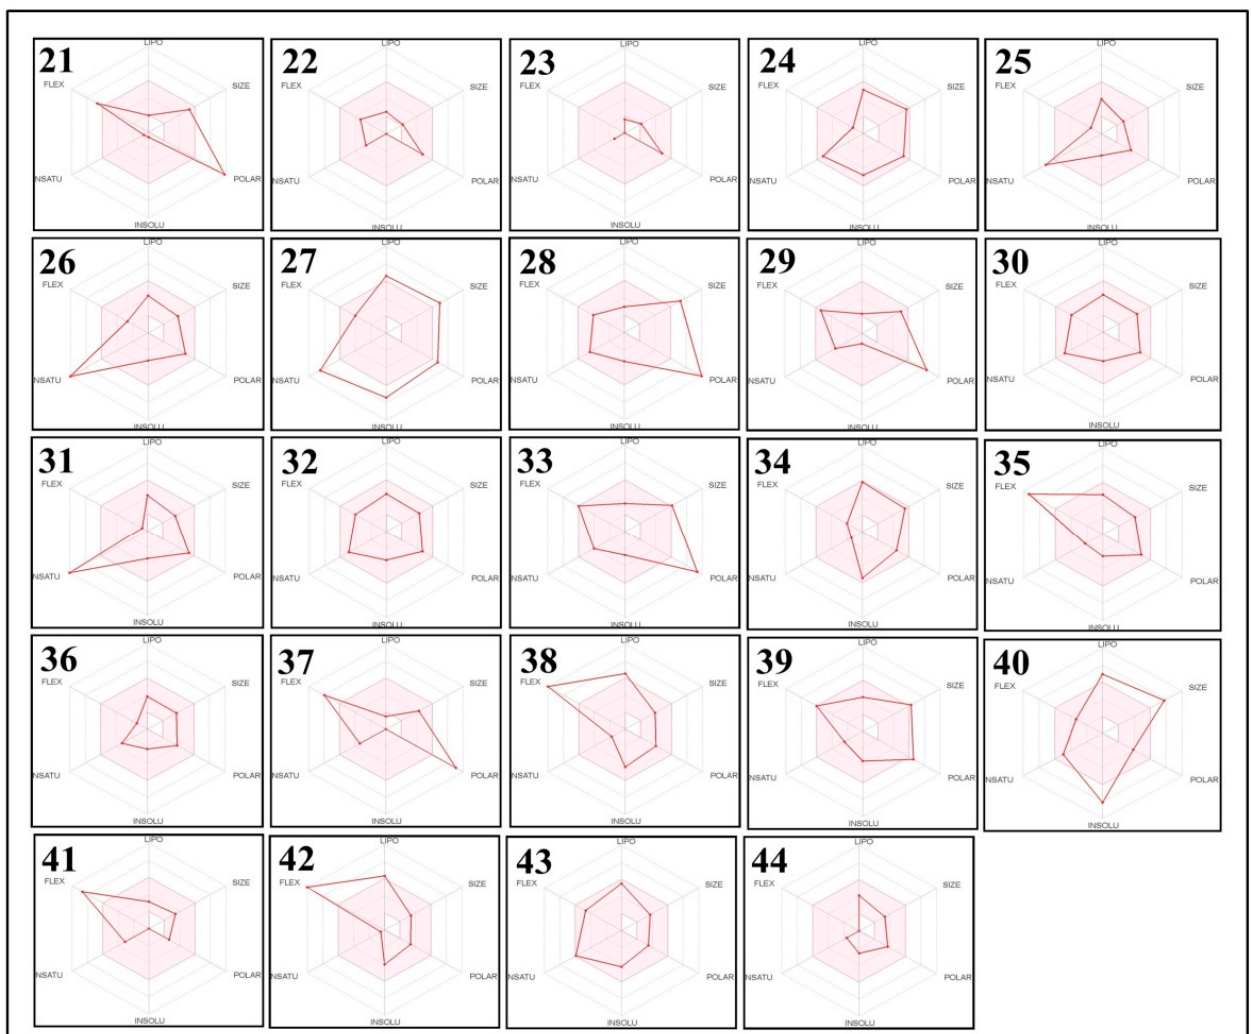
Figure 7. Bioavailability radar of the phytochemical compounds of E. sativa based on the physico- chemical indices ideal for oral bioavailability. The pink area represents the optimal range for each property (lipophilicity: XLOGP3 between − 0.7 and +5.0; size: MW between 150 and 500 g/mol; polarity: TPSA between 20 and 130 Å 2 ; solubility: log S not higher than 6; saturation: fraction of carbons in the sp3 hybridization not less than 0.25; and flexibility: no more than 9 rotatable bonds). (21) Glucoraphanin; (22) (S)-2-(Hydroxymethyl)glutarate;, (23) 2-Deoxy-scyllo-inosose; (24) arto- munoxanthentrione epoxide; (25) fraxidin; (26) N -(6-Oxo-6H-dibenzo[b,d]pyran-3-yl) maleamic acid; (27) sciadopitysin; (28) rutin; (29) 5 ′ -Butyrylphosphoinosine; (30) evoxine; (31) kaempferol 3- O - β - D -galactoside; (32) lactucin; (33) 1,4-Dimethoxyglucobrassicin; (34) pubesenolide; (35) corchorifatty acid F; (36) linifolin A; (37) N2-(2-Carboxymethyl-2-hydroxysuccinoyl)arginine; (38) 9Z-Octadecenedioic acid; (39) trilobolide; (40) thalidasine; (41) α -linolenic acid; (42) 16-Hydroxy hexadecanoic acid; (43) 4-(3-Hydroxy-7-phenyl-6-heptenyl)-1,2-benzenediol; and (44) (6beta,8betaOH)-6,8-Dihydroxy-7(11)-eremophilen-12,8-olide.